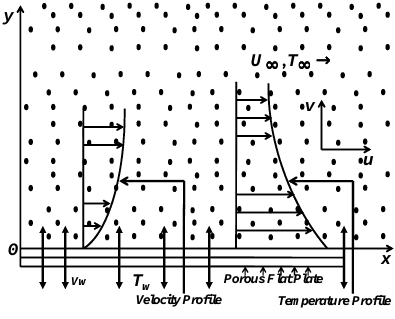
Figure 1. Schematic representation of the